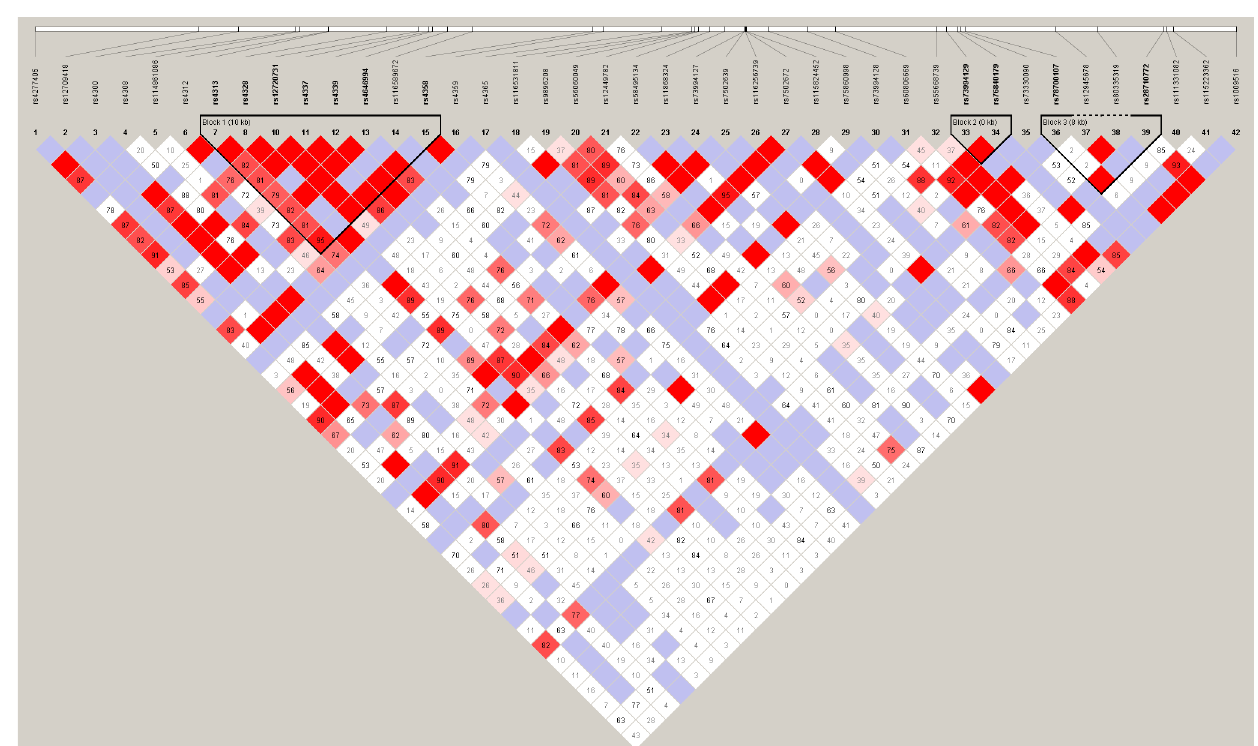
Fig 1. The LD block distribution of 31 SNPs and one Alu insertion polymorphism assayed in the ACE gene. Haplotype blocks are outlined in black. Darker shades of pink and red indicate a higher confidence in Hedrick’s multiallelic D’ measure of LD and a higher likelihood of LD. White and blue represent very low likelihoods of LD. Block 1 (far left) extends 10 kilobases (kb) and includes SNPs rs4313 to rs4358 and the ACE Alu insertion polymorphism (rs4646004).